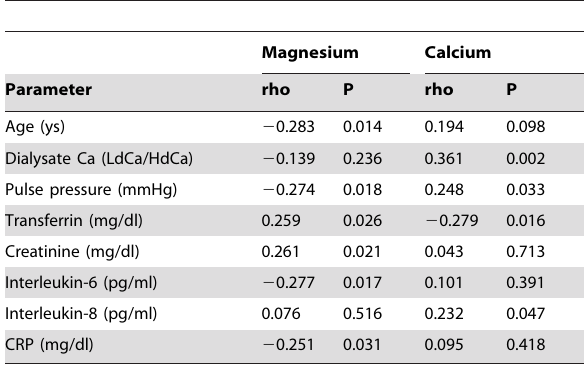
Table 3. Correlations of serum magnesium and calcium with selected baseline parameters.